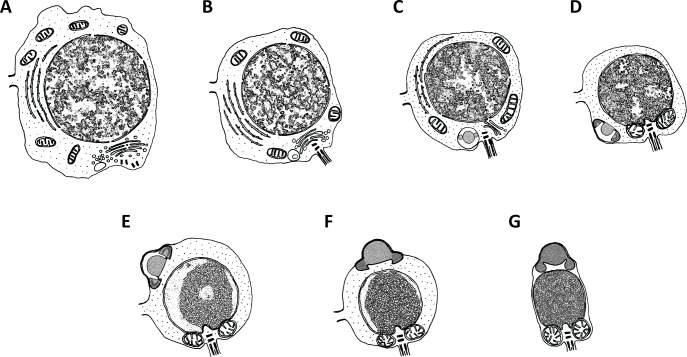
Illustrations showing the pattern of spermiogenesis in G. gemineoa.Spermiogenesis can be temporally divided into (A—B) Golgi phase, (C—E) acrosomal phase and (F—G) maturation phase. (A) In early Golgi phase, a large number of single-membrane bound vesicles are observed adjacent to a conspicuous Golgi complex. These vesicles gradually merge into an electron-lucent proacrosomal vacuole. A pair of centrioles, which were initially located in close proximity to the nuclear membrane, migrate towards the cell membrane. (B) In the late Golgi phase, the fusion of proacrosomal vesicles ceases and a patch of electron-dense material forms in the matrix of the proacrosomal vacuole. The distal centriole docks to the cell membrane, where a formative flagellum subsequently protrudes out. (C) In early acrosomal phase, the Golgi complex becomes no longer involved in the differentiation of the acrosome and the proacrosomal vacuole transforms into a proacrosome containing a large sphere surrounded by a ring-like structure. The chromosomes decondense into rod-shaped chromatin blocks and occupy half volume of the nucleoplasm. (D) The proacrosome transforms into an inverted-bowl shaped acrosome, during which both the central sphere and the ring structure attach to the inner posterior membrane of the acrosome. The proximal centriole comes into intimate contact with the implantation fossa formed at the posterior end of the nucleus. After the fusion of mitochondria, they migrate to and adhere to concave recesses of the nucleus at the posterior pole. The acrosome starts to migrate towards the anterior pole of the cytoplasm after the adherence of the mitochondria. (E) In late acrosomal phase, the acrosome almost reaches the most anterior aspect of the spermatids. The chromatin condenses into a rough oval-shaped chromatin block. (F) In the early maturation phase, the acrosome has accomplished the majority of its differentiation, during which the central hemisphere comes to occupy the entire matrix of the acrosome. (G) In the late maturation phase, acrosome differentiation is completed and the nucleus is fully condensed. The excess cytoplasm is completely eliminated from the spermatid through the extrusion of residual bodies. The cytoplasmic bridge between the spermatids ruptures and the spermatids develop into individual spermatozoa.